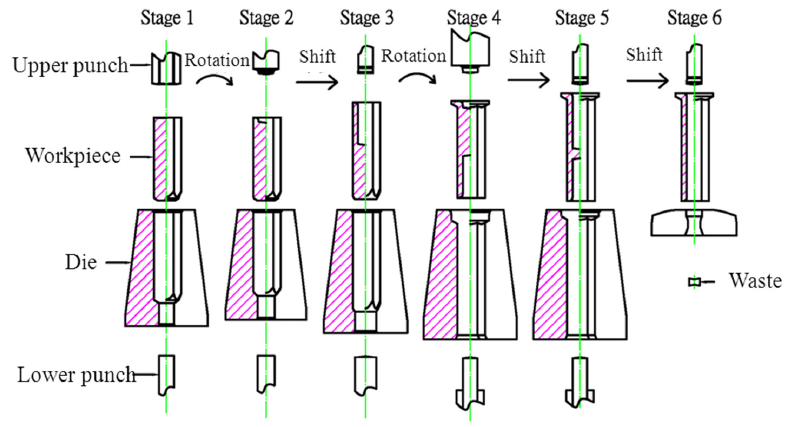
Figure 6. Schematic diagram of six-stage cold forging.